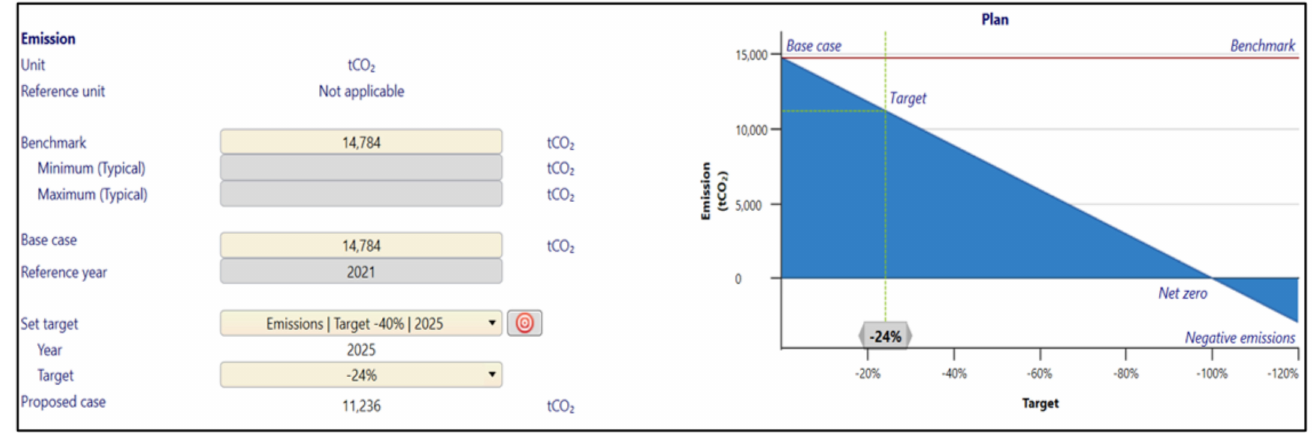
Figure 13. Photovoltaic system design target, 24% reduction in CO 2 eq